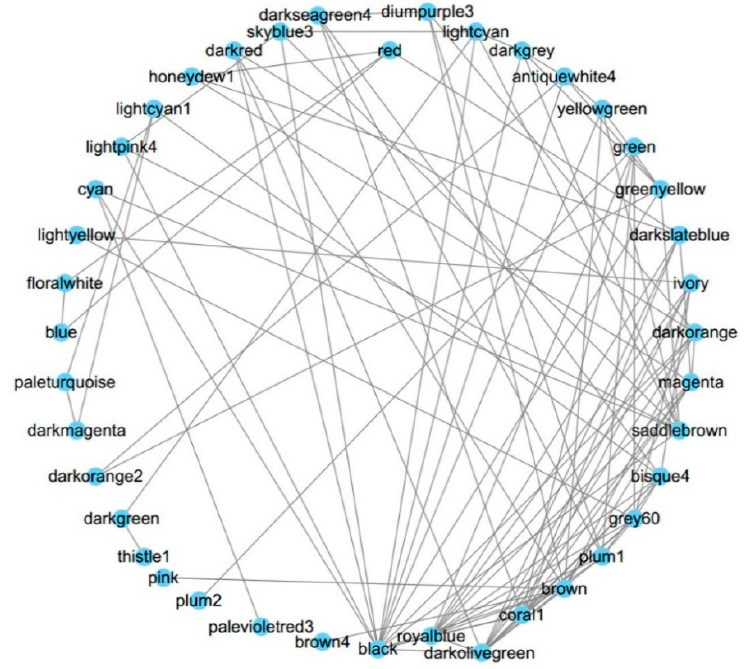
Figure 3. The network of modules. The higher order organization of the 48 modules was analyzed and the top 100 dense connections were visualized. the top 100 dense connections were